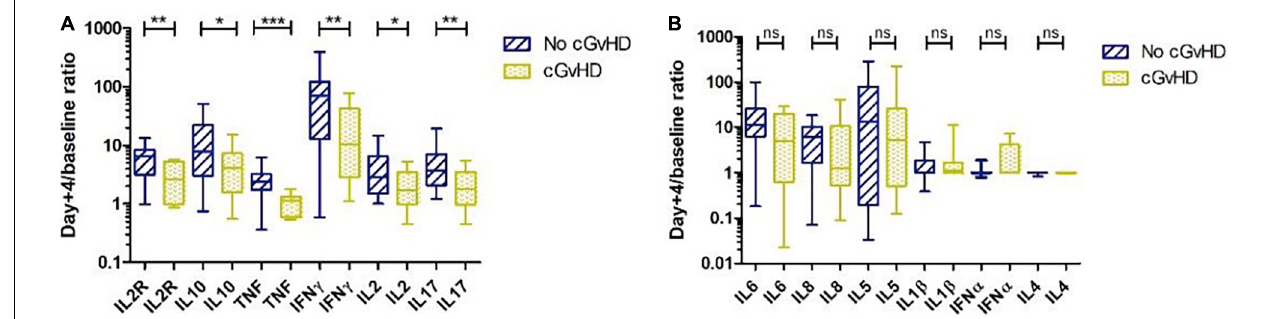
FIGURE 2 | Cytokine profile and chronic graft versus host disease (cGvHD). (A) Patients without cGvHD had significantly higher levels of interleukin (IL) 2R, IL10, tumor necrosis factor (TNF), IFN γ , IL2, and IL17 on day +4 than patients with cGvHD. (B) IL6, IL8, IL5, IL1 β , interferon (IFN) α , and IL4 on day +4 were comparable in patients with and without cGvHD. * p < 0.05, ** p < 0.01, *** p < 0.001, ns, not significant. TABLE 3 | The predictors of